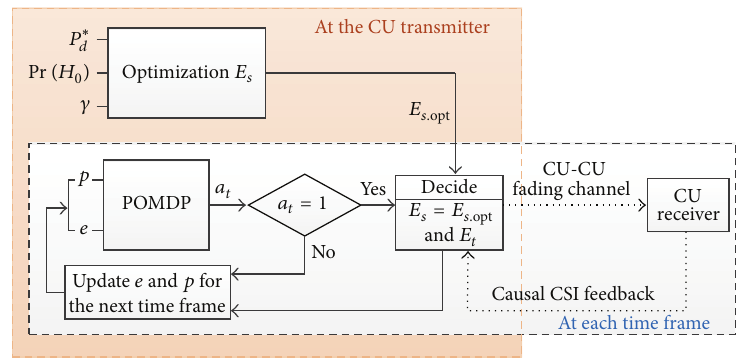
Figure 2: Flowchart of the proposed